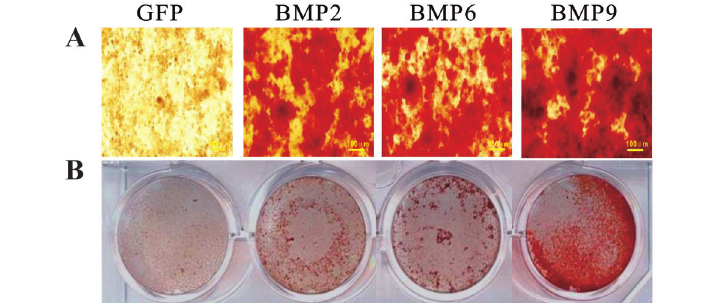
Figure 4. Bone morphogenetic proteins (BMPs) promote late-stage mineral deposition in immortalized preodontoblasts (iPDBs). Ad-BMP2, 6, 9, or Ad-GFP infected iPDBs were seeded in 24-well cell culture plates and then maintained in mineralization culture medium for 14 days and stained with alizarin red S ( A and B ). Representative images are shown (scale bars 100 m m). GFP: green fl uorescent